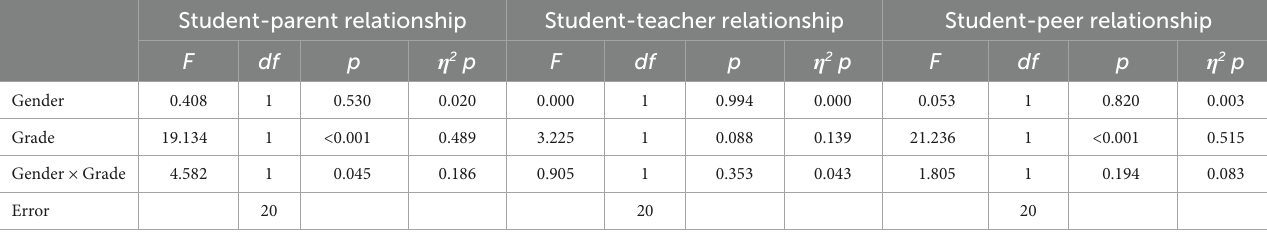
TABLE 5 ANOVA for gender and grade in relation to personal relationships and achievement. Student-parent relationship